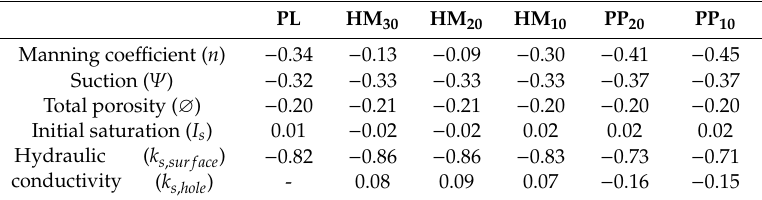
Table 5. Spearman’s correlation coe ffi cients ( ρ s ) between the runo ff coe ffi cient and input parameters for each configuration.